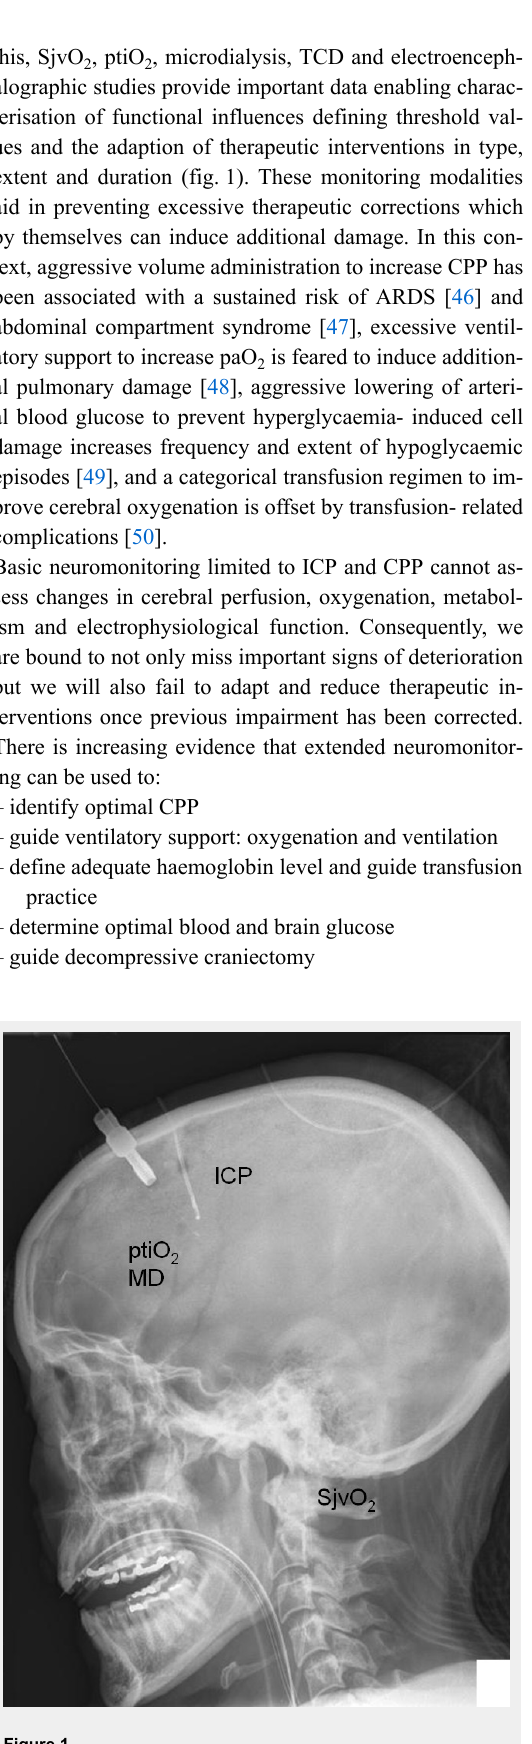
Illustrative lateral X- ray view showing positioning of ICP, ptiO 2 , microdialysis (MD), and jugular venous catheter allowing measurement of SjvO 2 . This allows to combine local (ptiO 2 , microdialysis) with global neuromonitoring (SjvO 2